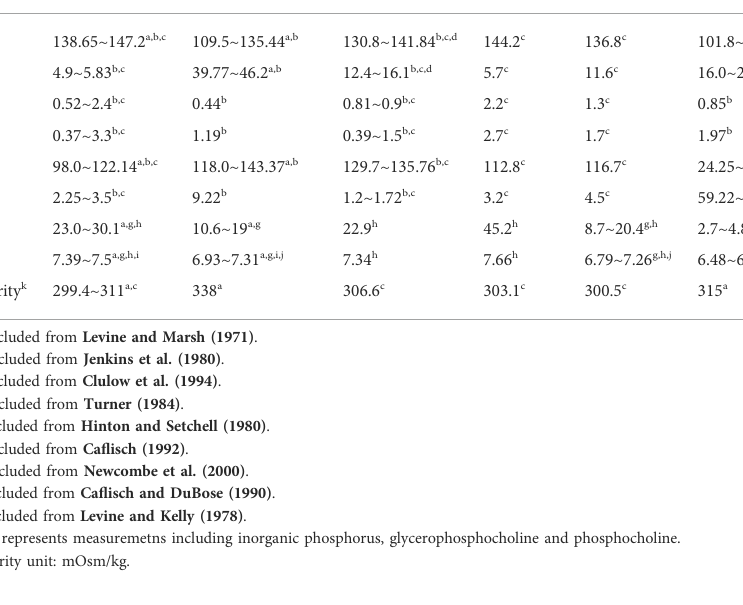
TABLE 1 Concentrations of inorganic elements (mM) and pH in blood plasma and intraluminal fl uids from the excurrent duct of rats.